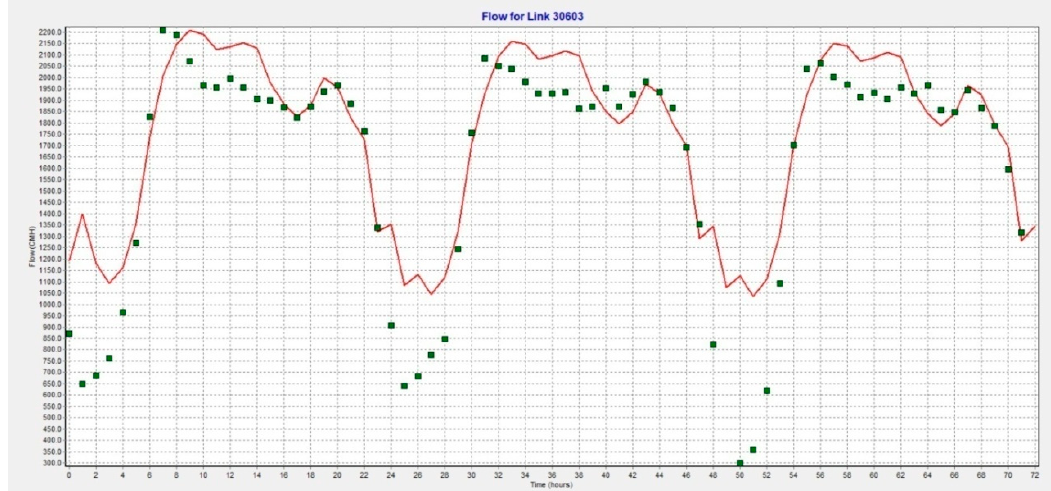
Figure 6. Results of Scenario I for Tanks E, east direction.